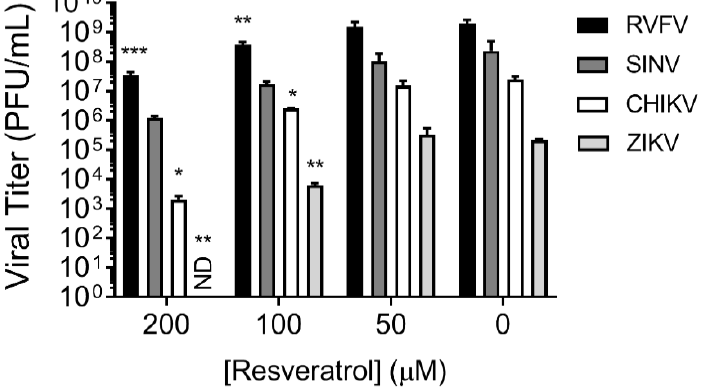
Figure 6. The broad-spectrum antiviral activity exerted by resveratrol. Viral titers of Sindbis virus (SINV), chikungunya virus (CHIKV), Rift valley fever virus (RVFV), and Zika virus (ZIKV) were evaluated at 24 h.p.i. after resveratrol treatment at concentrations from 0 to 200 µ M. ND, undetectable. * p < 0.05; ** p < 0.01; *** p < 0.001 compared to no-resveratrol-treated groups by one-way